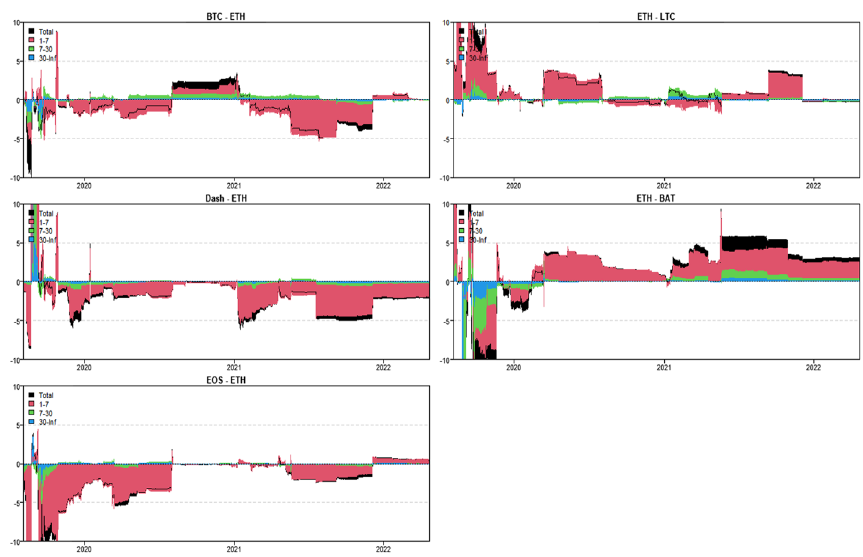
Fig. 20 Dynamic net-pairwise connectedness—signed jump variation